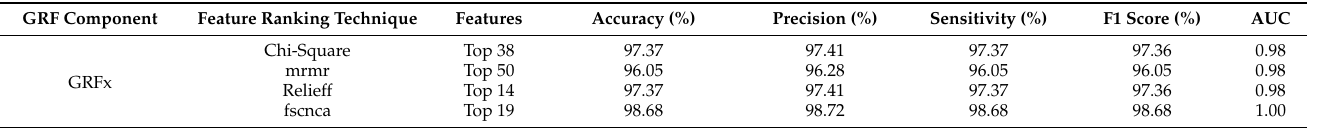
Table 7. Evaluation matrix for one-channel analysis for GRF data using different feature selection